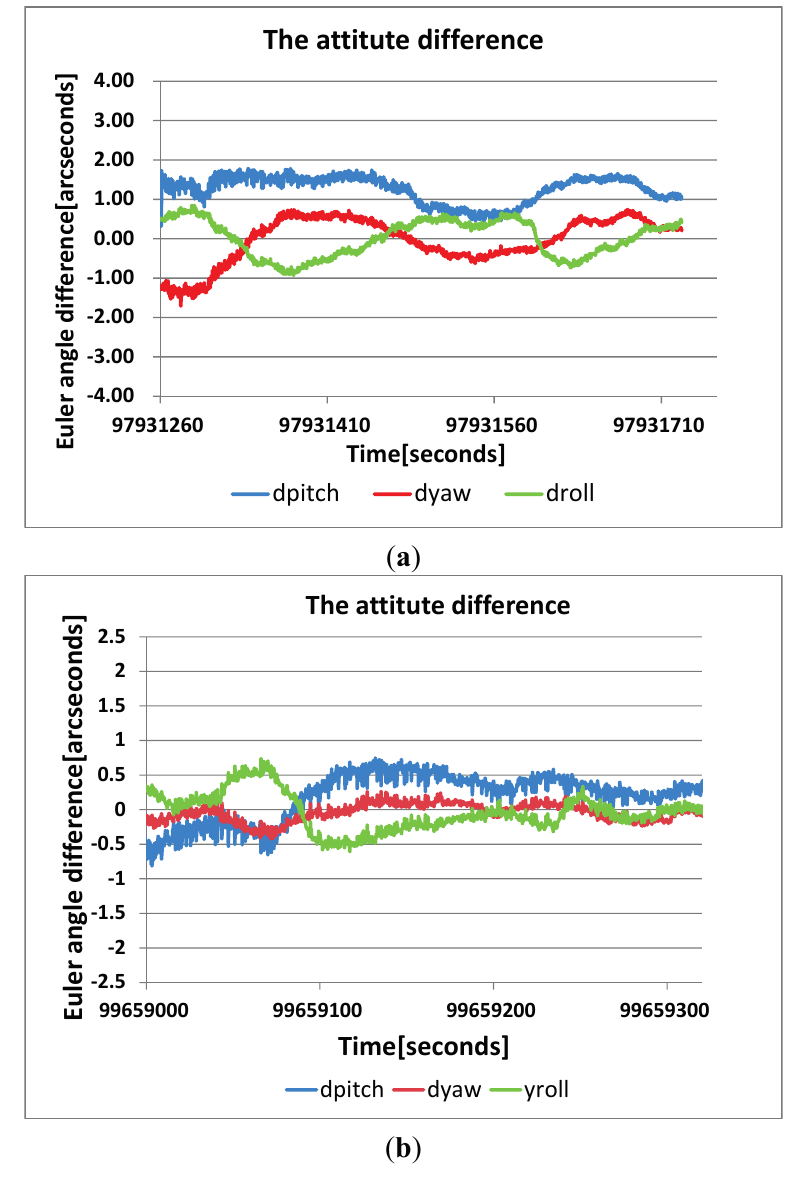
Figure 9. Attitude difference between the on-board and post-processed results (Euler angle). ( a ) Attitude difference (the457th track); ( b ) attitude difference (the 785th